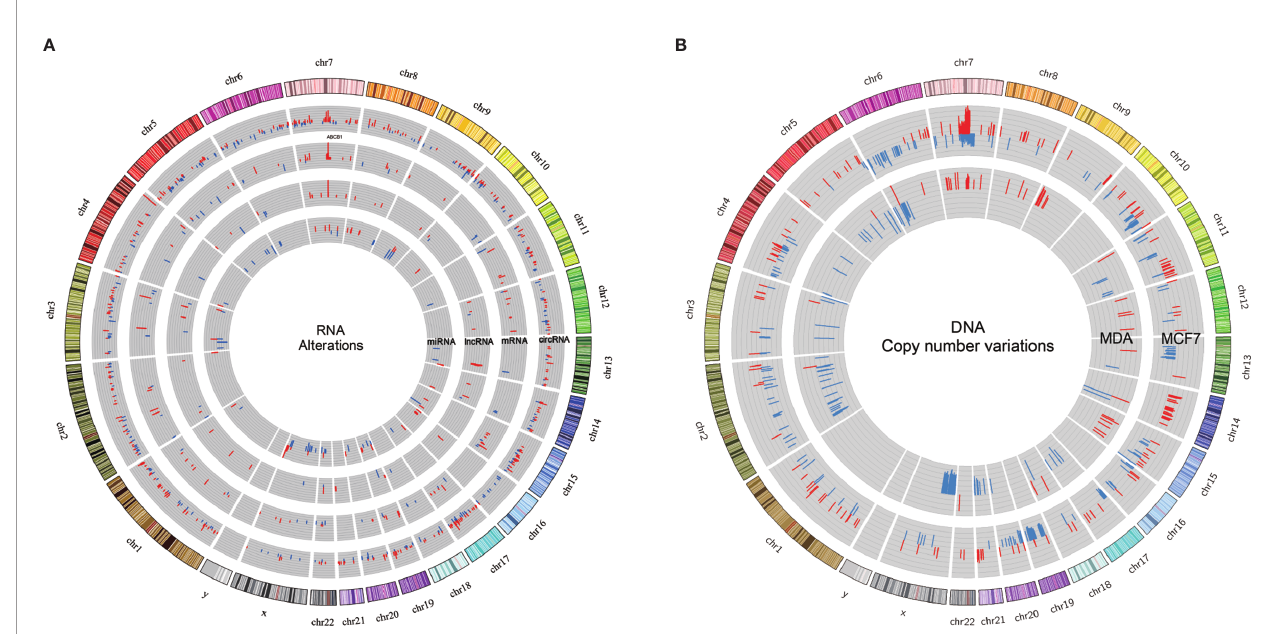
FIGURE 6 | Integrated pro fi le of RNAs and copy number variation. (A) Expression pro fi les of miRNA, lncRNA, circRNA and mRNA in DRBC cell lines. The fi rst (outermost) circle represents the genome location. And the second to the fi fth circles show SDE circRNA, mRNA, lncRNA and miRNA. All signi fi cantly expressed RNAs were obtained by comparing resistant samples against the corresponding sensitive samples, with red and blue bars for increased and reduced expression, respectively. (B) DNA copy number variations in MCF7 and MDA cell lines are depicted by the outer and inner circles, with the blue and red bars representing deletion and ampli fi cation, respectively.